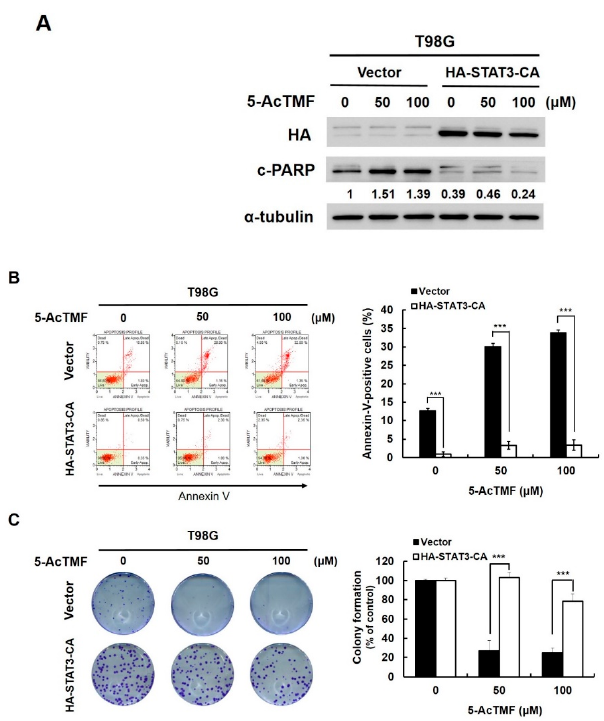
Figure 3. Essential role of STAT3 suppression in the anti-GBM e ff ect of 5-AcTMF. ( A ) Constitutive STAT3 activation impaired 5-AcTMF-elicited apoptosis. T98G clones stably carrying an empty